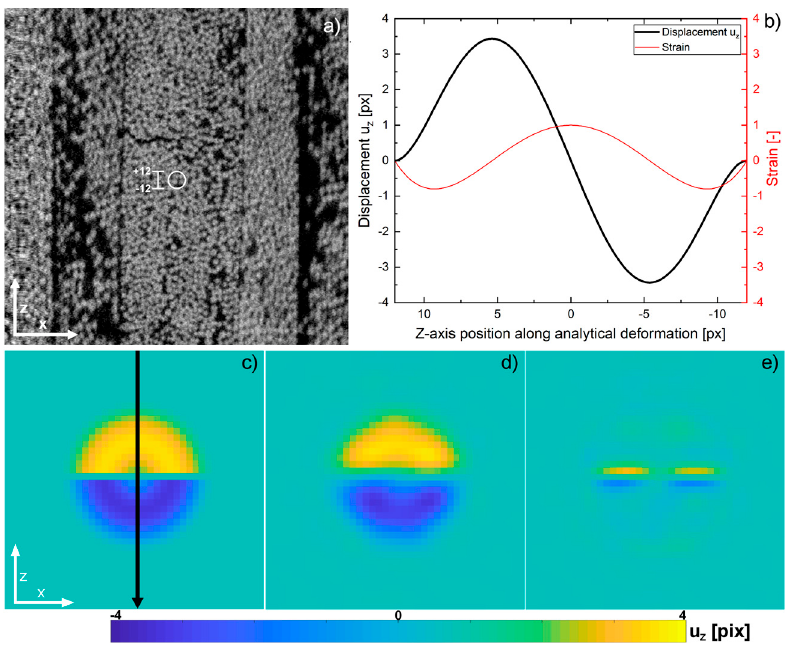
Figure 4. The region of the analytical deformation is marked in the reference CT slice ( a ). The displacement within this deformation ranges from − 3.5 to +3.5 px with a max. strain of one in the center. The graph ( b ) shows a line plot through the center of the analytical deformation. The central xz-slice of the manufactured solution together with the position of the line profile ( c ), the displacement field obtained from DVC ( d ) and the residuals between the former ( e ).